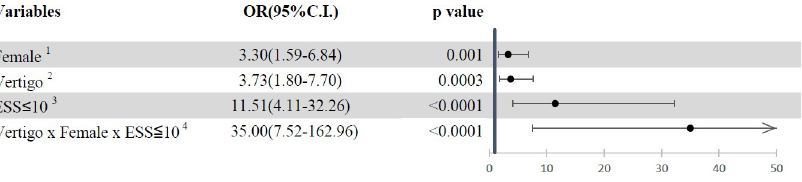
Fig 1. Odds ratios of potential risk factors of REM-related OSA. 1: ref = male; 2: ref = non-vertigo; 3: ref = ESS > 10; 4: ref = without any risk factors of female, vertigo or ESS � 10; OR, odds